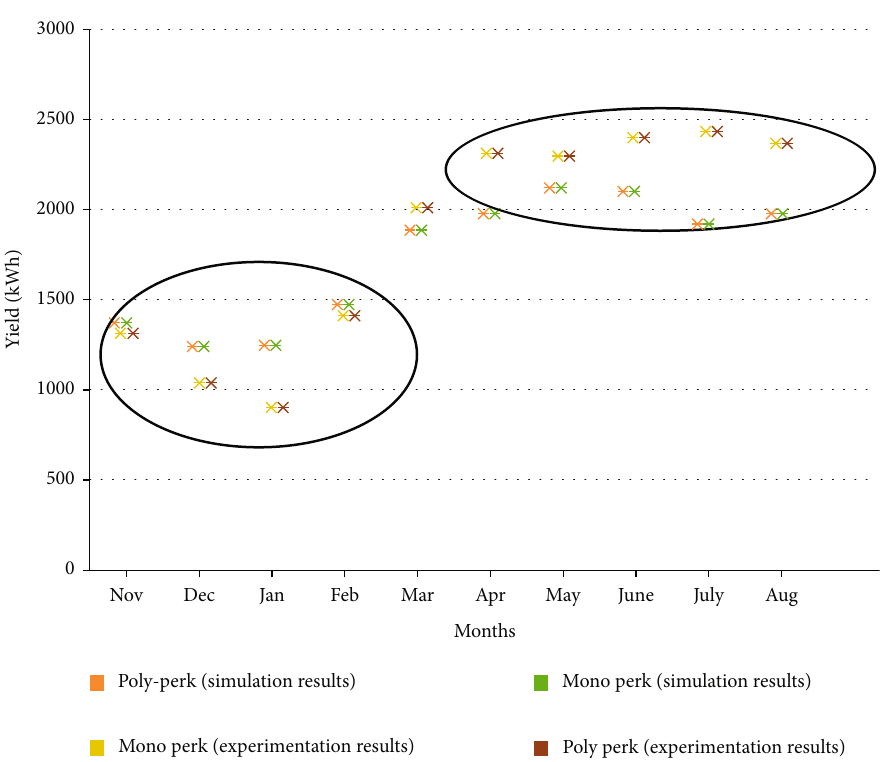
Figure 4: Comparison of hotspots generated by mono- and polyperk on monthly basis using real-time installed systems and simulations.